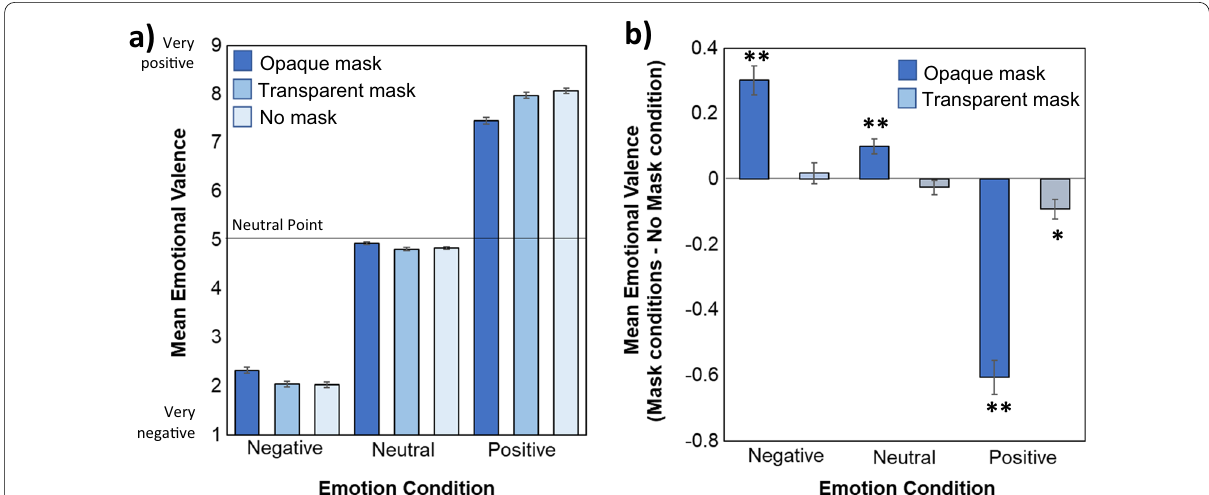
Fig. 2 a Assumed emotional valence of protagonists during each Emotion and Mask condition on a scale from 1/very negative to 9/very positive. b Comparison of valence ratings for protagonists wearing opaque and transparent masks relative to those with no masks as a baseline for each Emotion condition (calculated via subtracting the no mask baseline from the mask conditions). Larger magnitude bars indicate a larger difference relative to the no mask condition, with * and ** indicating a significant difference from the No mask condition at p < .05 and p < .01, respectively. Error bars represent standard error of the